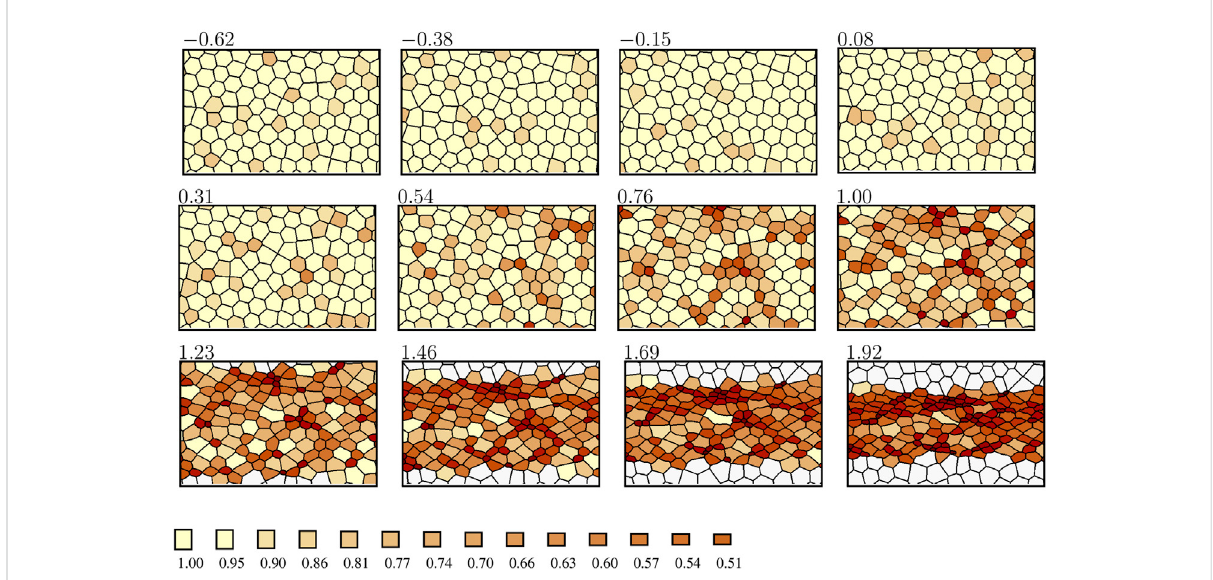
FIGURE 6 Evolutionofconstrictionpatterns,aspredictedbytheenhancedAGFmodel.Theactivecellsarecolor-codedbythevalueoftheareareduction factor r A (color bar); the passive cells are indicated in white. The time zero corresponds to the onset of ratcheted constrictions, and the time is normalized by the time at which 40% of cells are constricted at the level r A = 0.65. The anteroposterior axis is horizontal. Only a portion of the simulation domain is